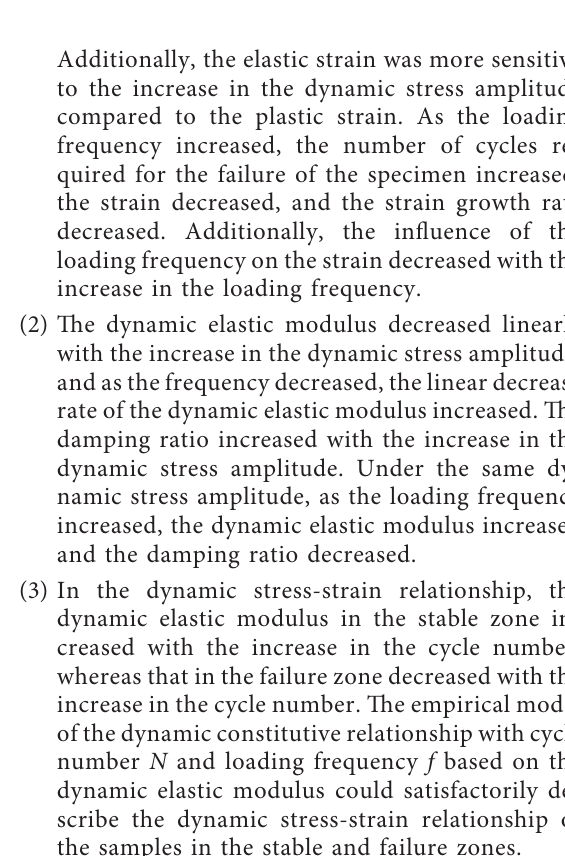
Figure 14: Curves of fitting parameters of dynamic elastic modulus versus frequency. (a) Stable curve-fitting parameters. (b) Failure curve- fitting